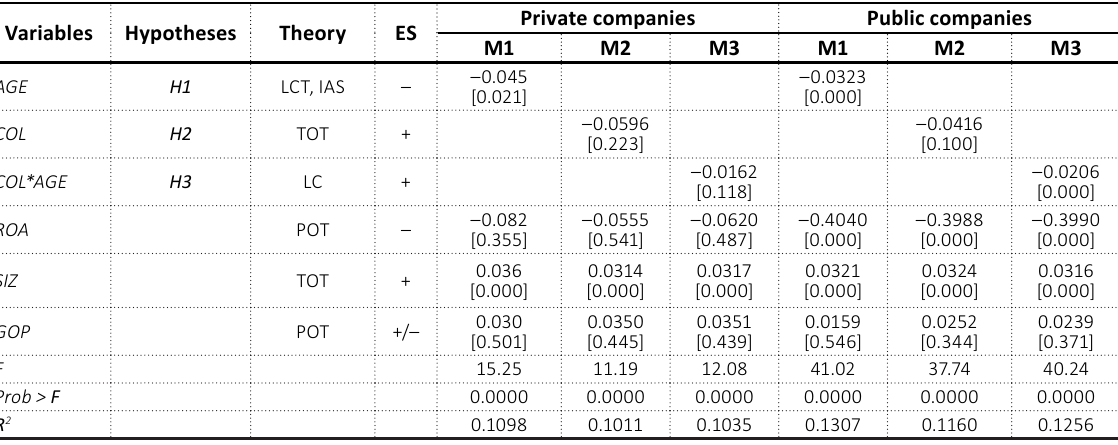
Table 5b. Cross-section pooled regression for total sample